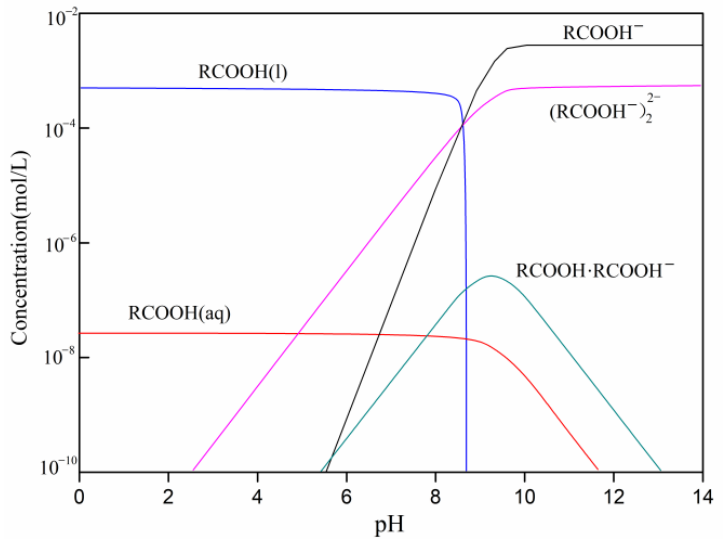
Figure 10. Hydrolysis species distribution of NaOl in aqueous solutions as a function of pH.